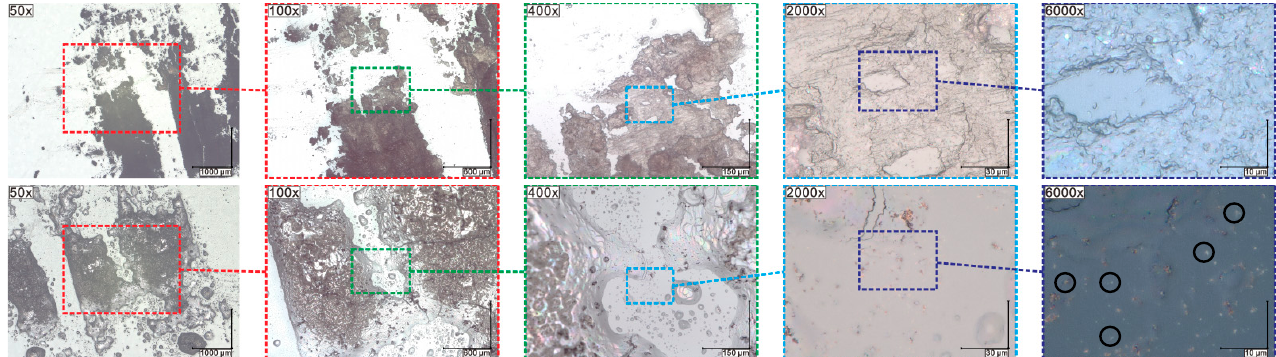
Figure 8. Room temperature digital optical images with coaxial illumination for those pristine ( the first row ) and cooled to room temperature after being heated to 155 °C and kept at this temperature for 5 min in Composite 3 ( second row ). The colored dotted squares represent the enlarged areas.